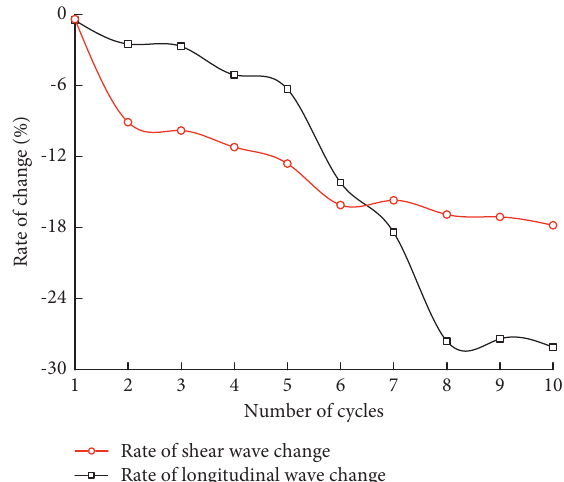
Figure 5: Loss rate curves of the wave velocity of weakly cemented sandstone under different numbers of dry-wet